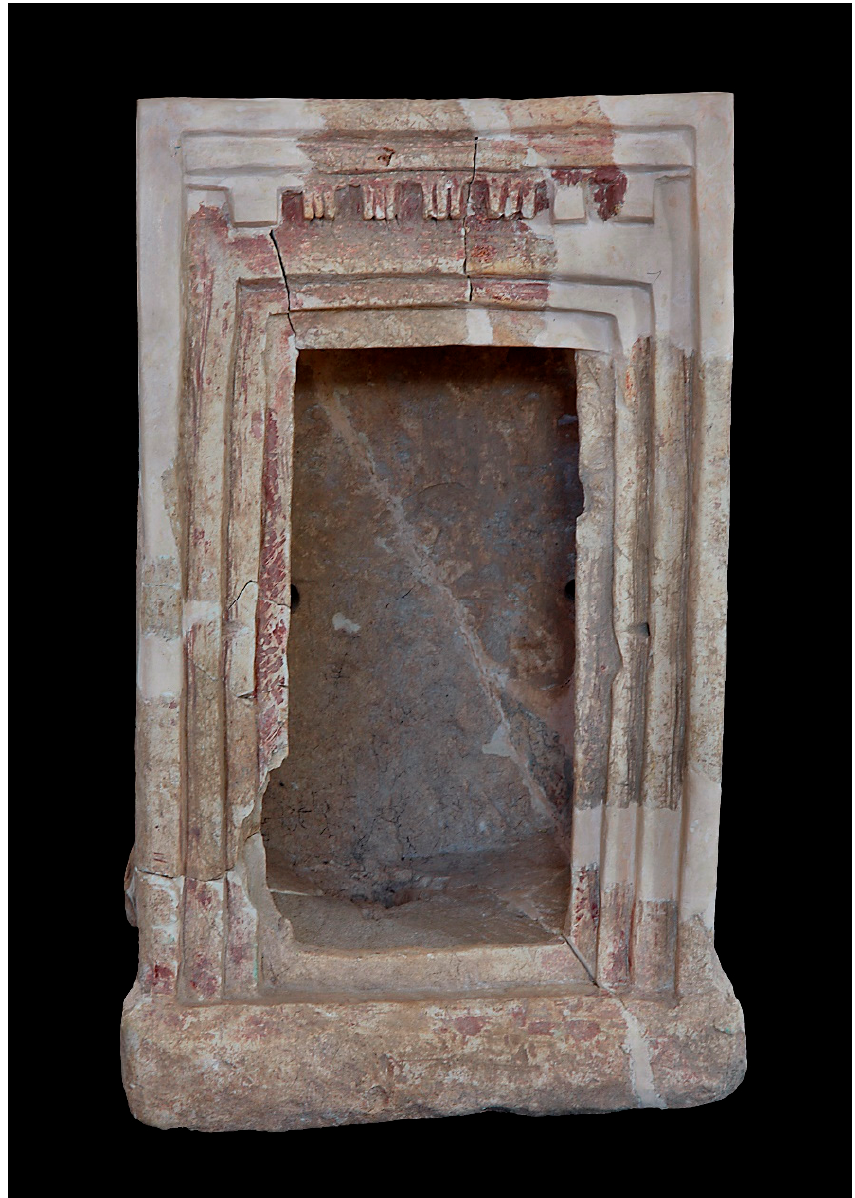
Figure 6. The façade of the stone building model from Khirbet Qeiyafa (Photograph by Gabi Laron).